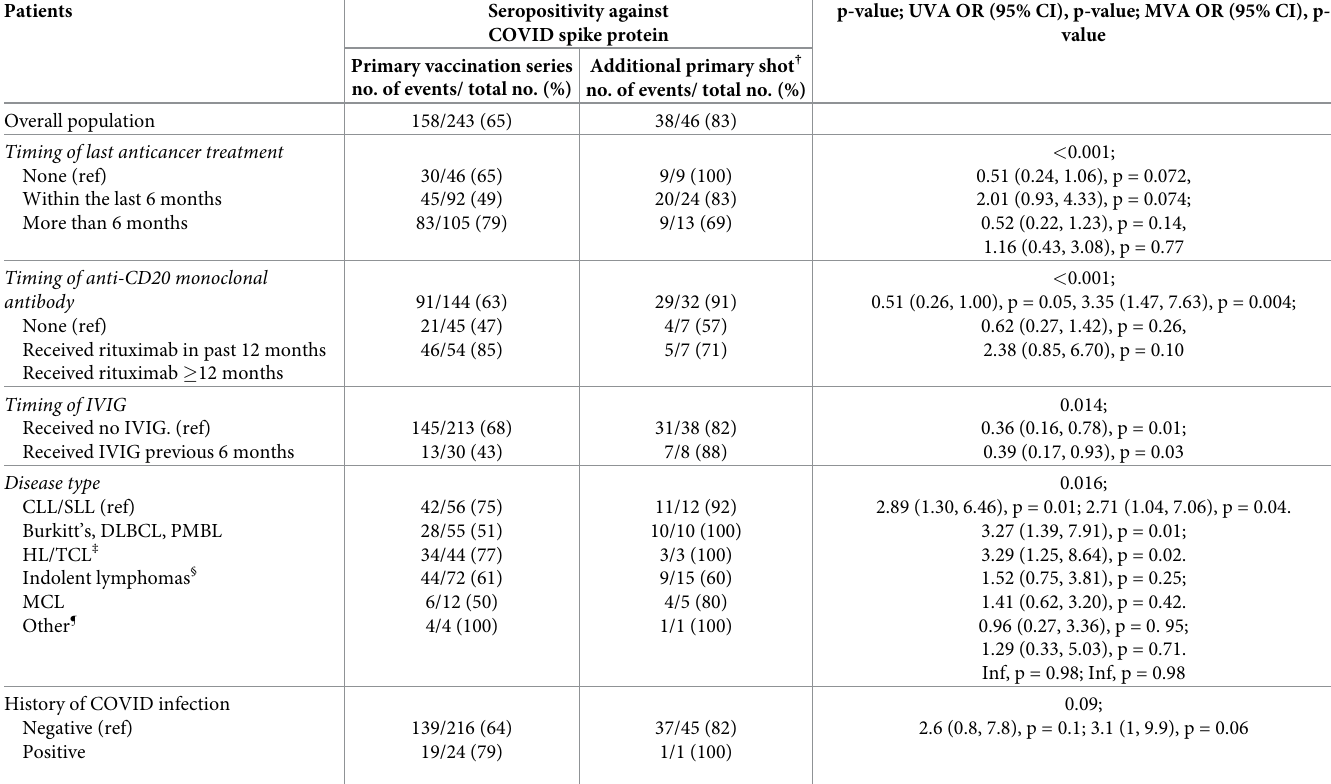
Table 2. Results.